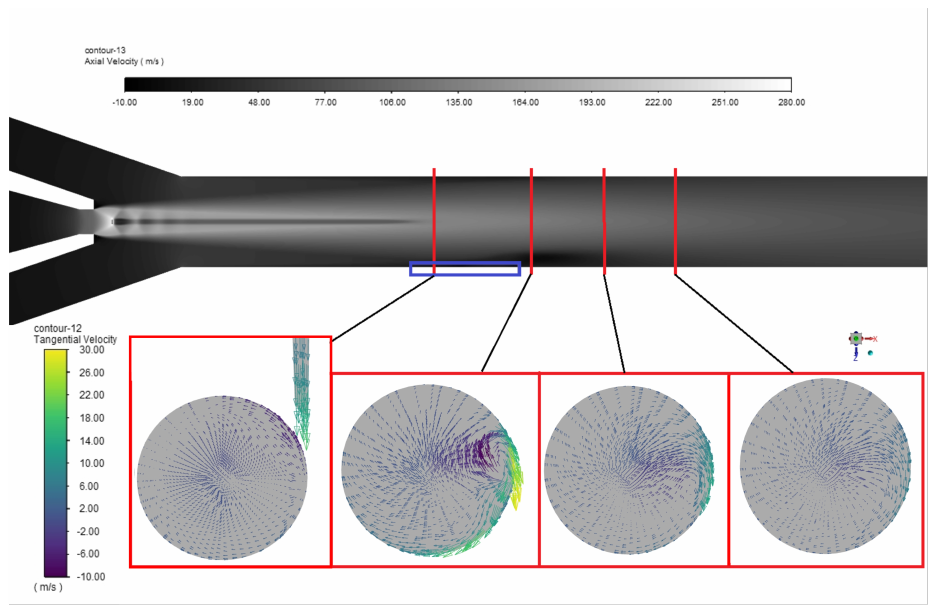
Figure 9. Top : Contour plot of the axial velocity in gray. The bypass inlet is colored blue. Bottom : Cross-sectional vector plots of the tangential velocity shown for locations along the ax- ial direction after the bypass